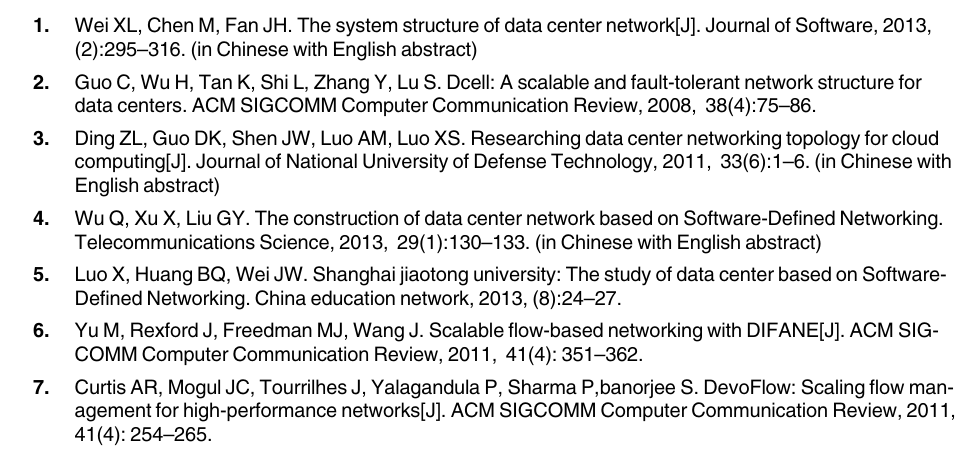
S1 Fig. The structural composition of flow table. A Flow table is a forwarding table which consists of multiple flow table items. Each item has its own execution action that is issued by the centralized